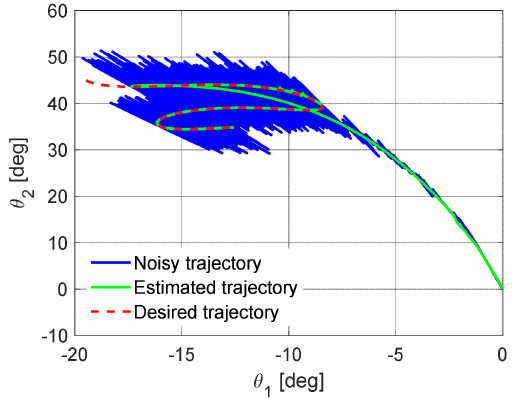
Figure 16. Noised, estimated, and desired trajectories of ARS—LQG